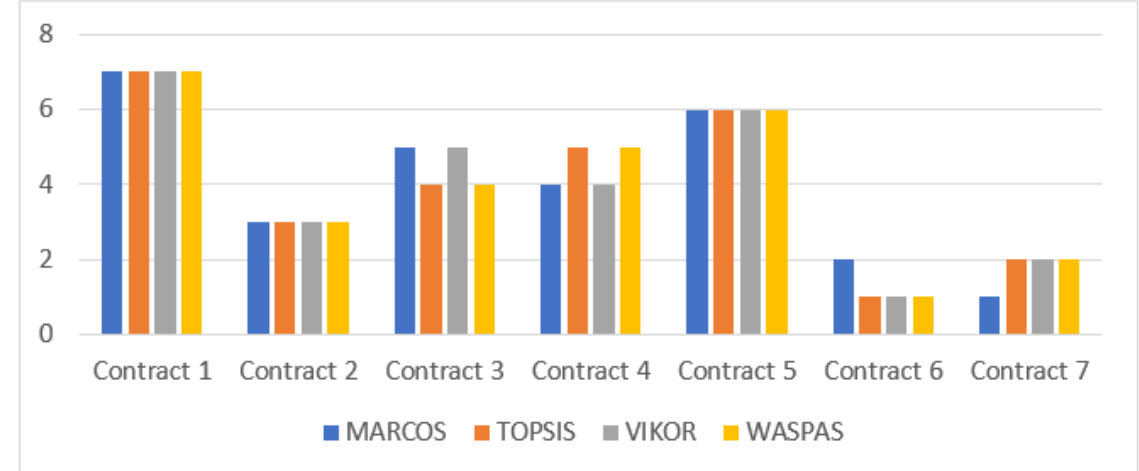
Figure 4. The results from different MCDM methods.